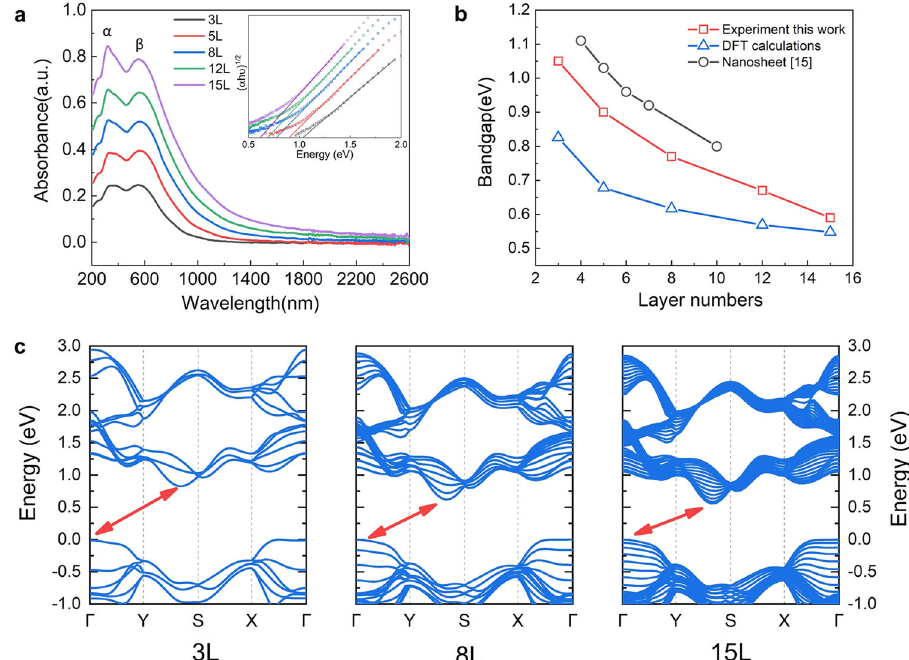
Fig. 3 Layer-dependent bandgap of PdSe 2 fi lms. a Absorption spectra and the Tauc plot (inset) of PdSe 2 fi lms with layer numbers from 3L to 15L. α and β represent the two prominent absorption peaks of PdSe 2 fi lms. b The optical bandgap identi fi ed from the Tauc plot (red line) and DFT calculation (blue line) versus layer number. The bandgap of the PdSe 2 nanosheet is presented for comparison (gray line). c DFT calculated the energy band structure of PdSe 2 , and the red line shows the indirect bandgap of PdSe 2